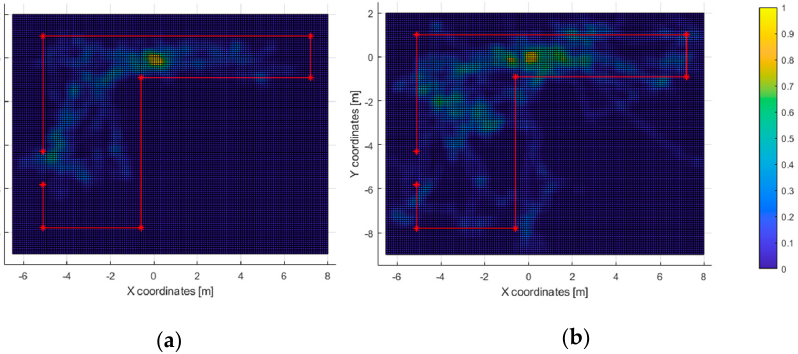
Figure 12. Test 2—Path heatmaps of those who passed the test ( a ) and those who did not ( b ). Spatial resolution: 5 cm. Low-pass FIR: 9 × 9 cell flat impulse